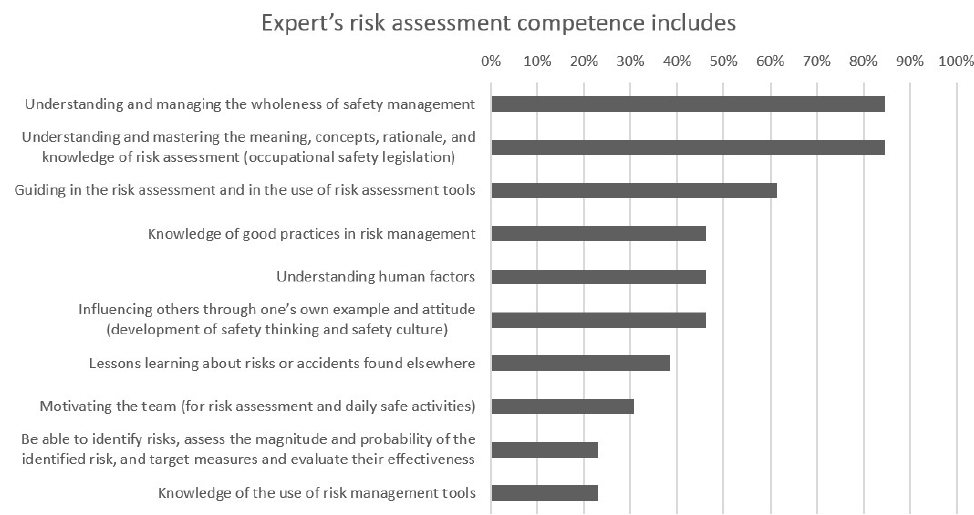
Figure 3. Opinions of the occupational health specialists and managers on the most important risk assessment skills needed by the expert.